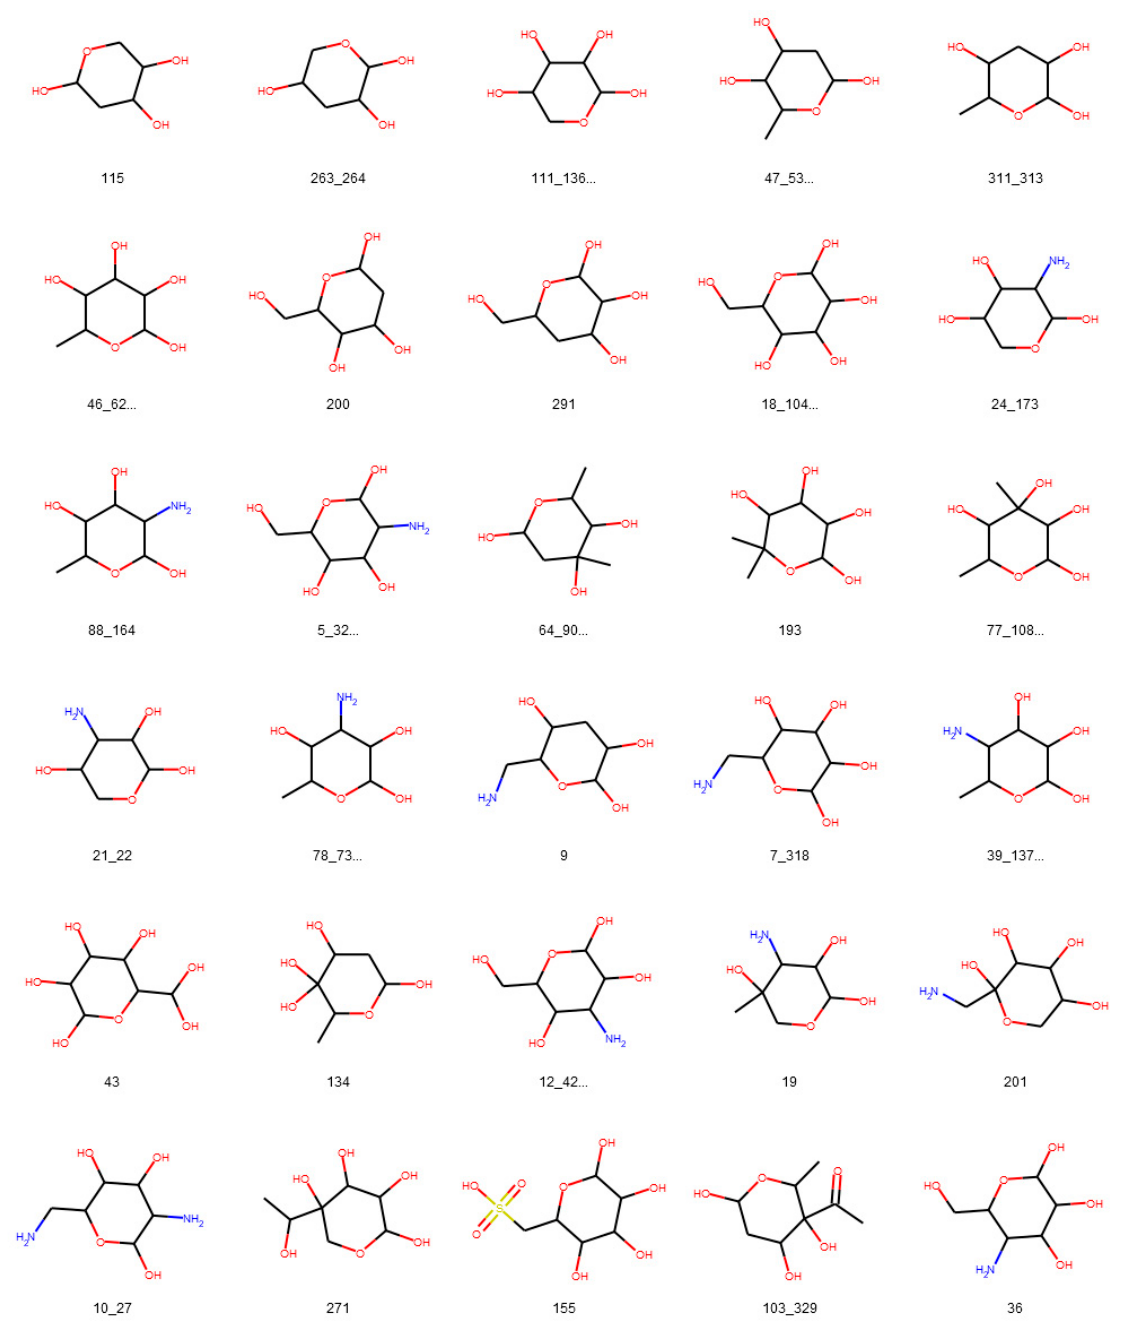
Figure 13. Glycosidic moieties reported in bacterial NPs detected at least ten times in COCONUT and detectable with the default SRU settings. All moieties are arranged for decreasing frequency in COCONUT, corresponding to the blue bars in Figure 12. The ID below the structures refers to the identifiers used in the original publication of the dataset, concatenated where stereoisomers were grouped.